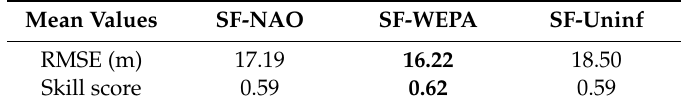
Table 2. Summary statistics containing the mean RMSE and skill score values for SF-NAO, SF-WEPA and SF-Uninf. The best results are highlighted in